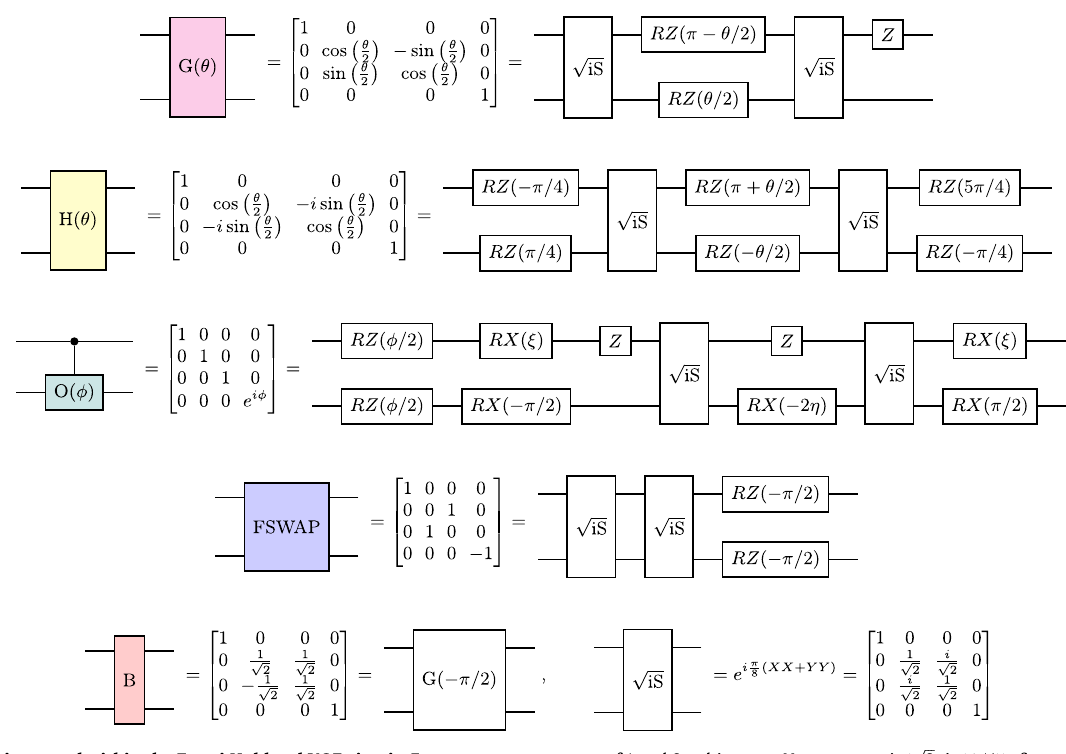
ffiffiffi p 2 sin ð ϕ = 4 ÞÞ , ξ = arctan ð tan ð η Þ =